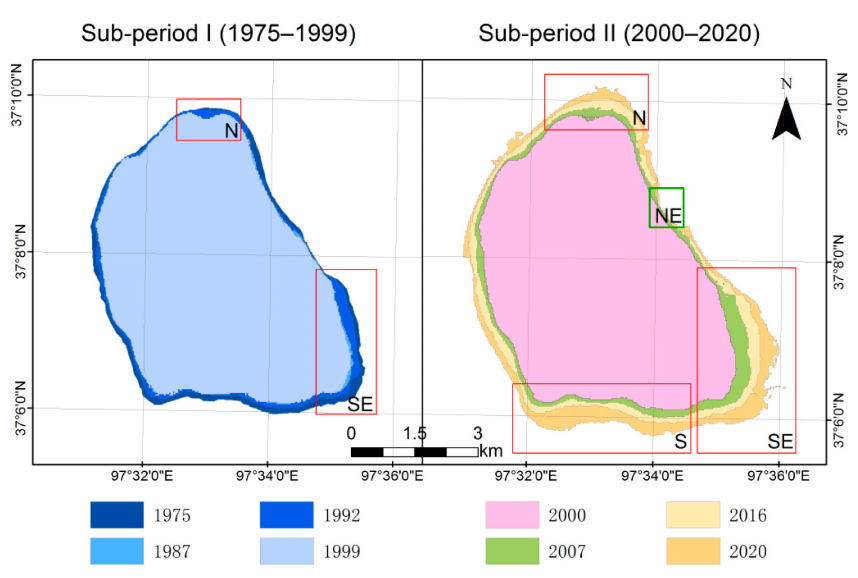
Figure 11. Spatial variations of Gahai Lake.